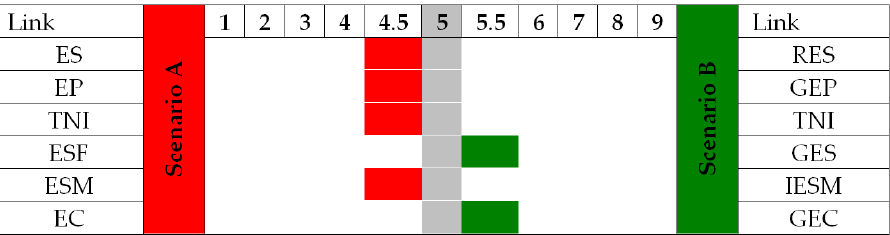
Figure 4. Aggregated expert opinions—assessment of the likelihood of a scenario (first item). Source: own calculation. Red color means the Red Ocean—Scenario A. Green color means the Green Ocean—Scenario B.